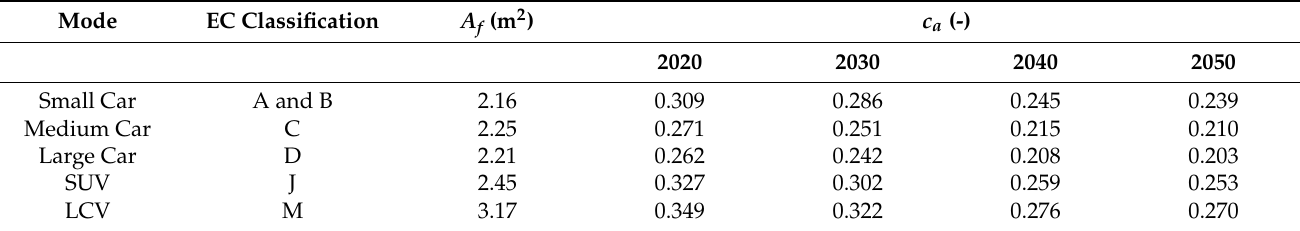
Table 1. LDV modes’ EC classification and the average aerodynamic parameters.